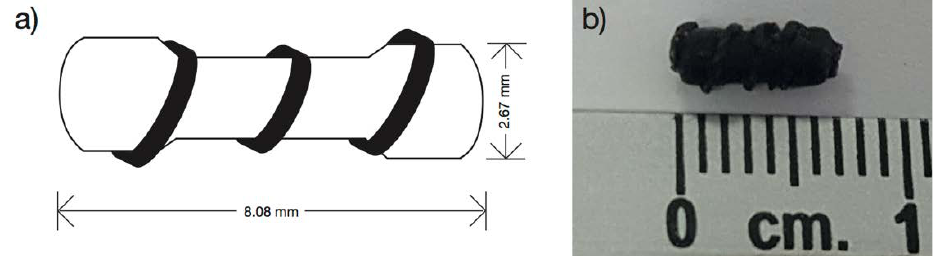
Figure 1. ( a ) Marker clip silicon cast design and ( b ) marker clip containing IONPs after 24 h of deep freeze.